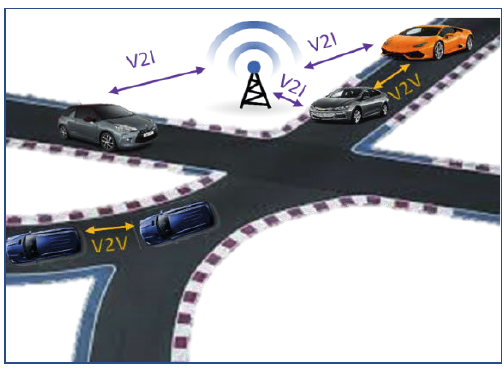
Fig. 2. VANET architecture.